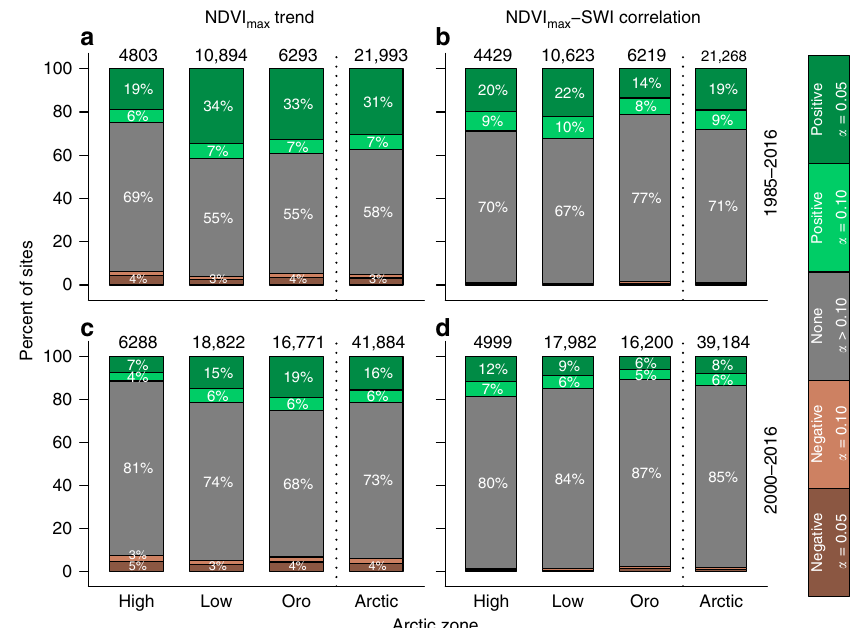
Fig. 3 Tundra greenness trends and correlations with summer air temperatures summarized by Arctic zone. Left panels show the percent of sites in the Arctic and each zone that exhibited a positive trend [green], a negative trend [brown], or no trend [gray] in Landsat NDVI max from 1985 to 2016 ( a ) and 2000 to 2016 ( c ). Right panels show the percent of sites that exhibited a positive correlation [green], a negative correlation [brown], or no correlation [gray] between annual NDVI max and the summer warming index (SWI) from 1985 to 2016 ( b ) and 2000 to 2016 ( d ). In all panels, dark and light shades denote signi fi cance levels of trends or correlations [dark shades: α = 0.05; light shades: α = 0.10). The sample size is provided above each